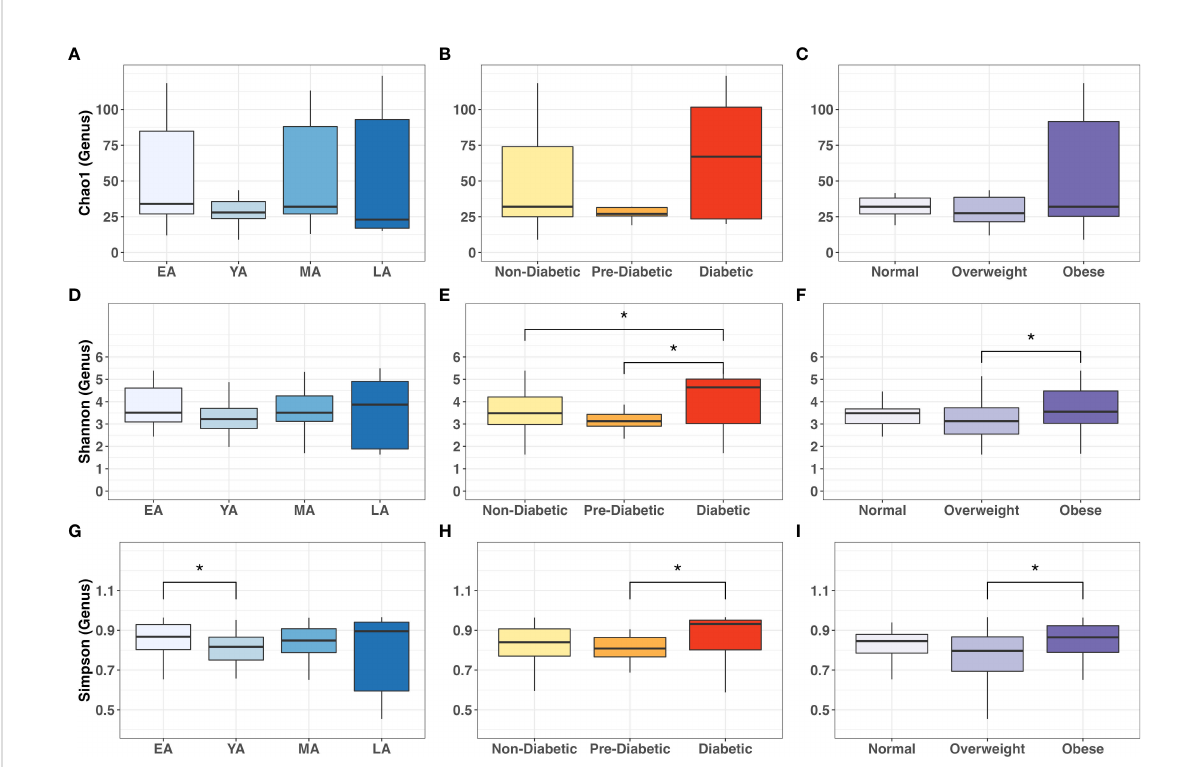
FIGURE 6 Intergroup comparisons for gut bacterial a -diversity at the genus level across age groups, T2DM categories, and BMI categories. Mean comparisons were performed across (A, D, G) age groups; (B, E, H) T2DM categories, and (C, F, I) BMI categories for Chao1, Shannon and Simpson indices, respectively. Statistical signi fi cance denoted: * ( P